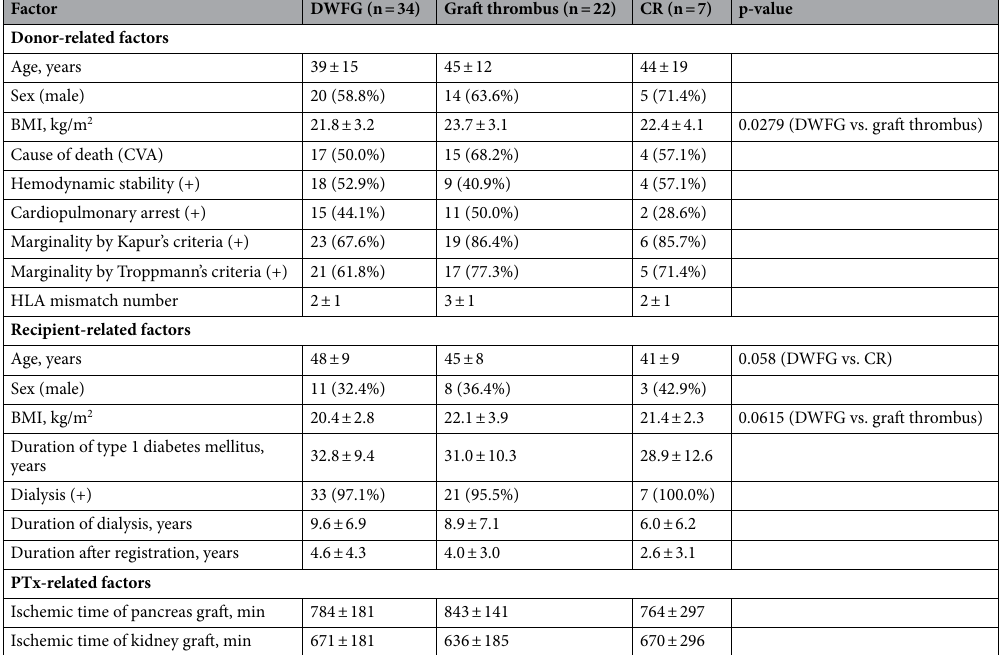
Table 2. Clinical characteristics of patients who lost pancreas grafts due to three major causes. Data are expressed as the number of patients (%) or the mean ± standard deviation. The differences between groups were assessed by chi-squared, Fisher’s exact test, or Mann–Whitney U test, as appropriate. p-values are shown only in the comparisons with p < 0.1 BMI body mass index, CR chronic rejection, CVA cerebrovascular accident, DWFG death with a functioning graft, HLA human leukocyte antigen, PTx pancreas